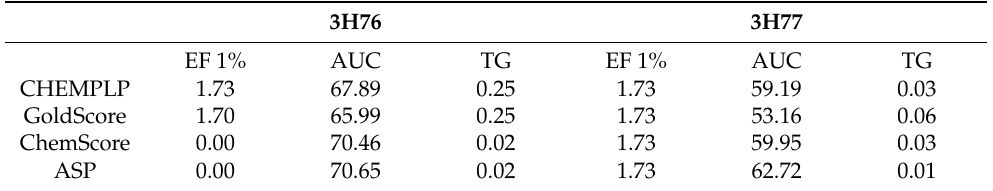
Table 2. Evaluation metrics for virtual screening results for x-ray structures for PqsD (3H76 and 3H77).